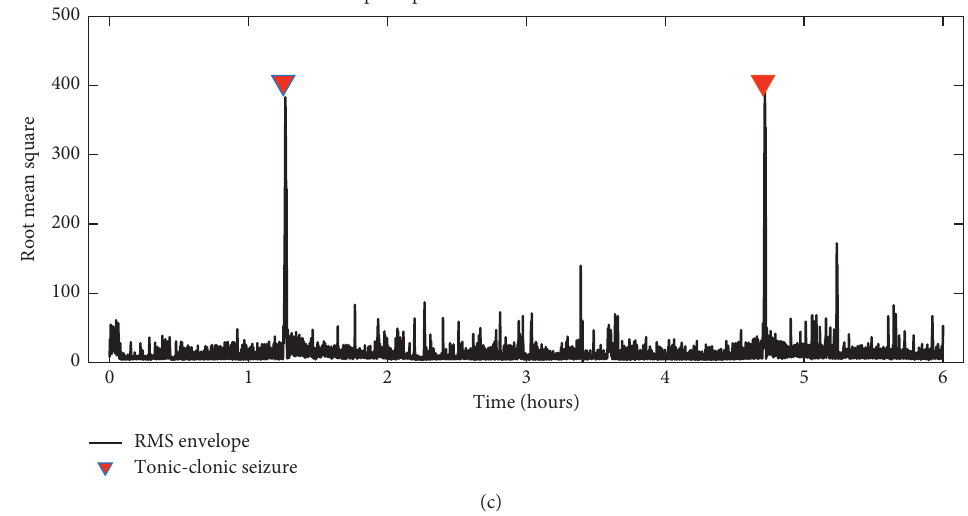
Figure 3: Detection of BTCS. (a) shows 80 seconds of a BTCS in the time domain. Superpositioned on the EEG signal, the bold black line shows the root mean square (RMS) envelope, which increases during the tonic-clonic phase of the seizure. (b) shows the time-frequency decomposition from a continuous wavelet transform of the same seizure. During the tonic-clonic phase, a high-frequency component can be observed, approaching the Nyquist frequency of the device (103.5Hz). (c) shows the RMS envelope of a six-hour epoch containing two BTCS indicated with red triangles. The RMS shows an abrupt increase only in close relation to these seizures, providing proof-of-concept that the device can be used for the detection of